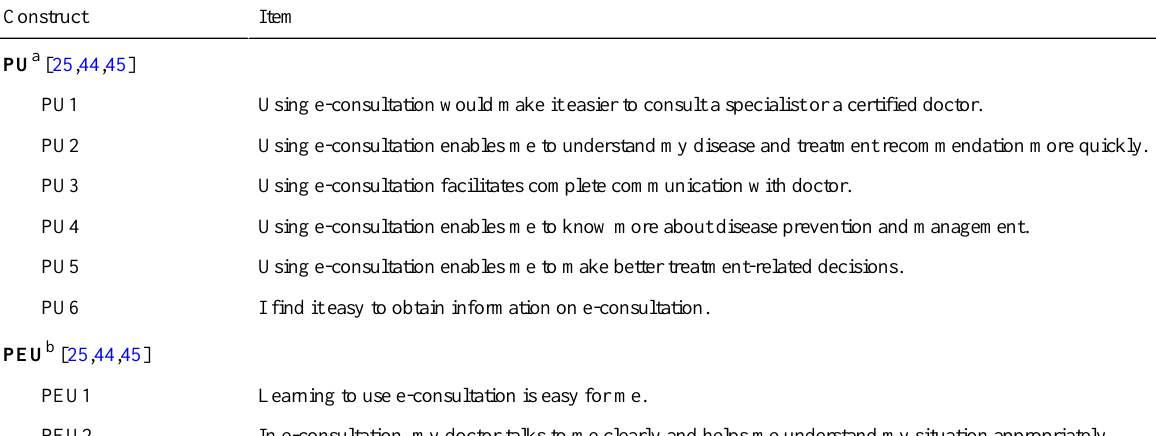
Table 1. Measurement items of the constructs.